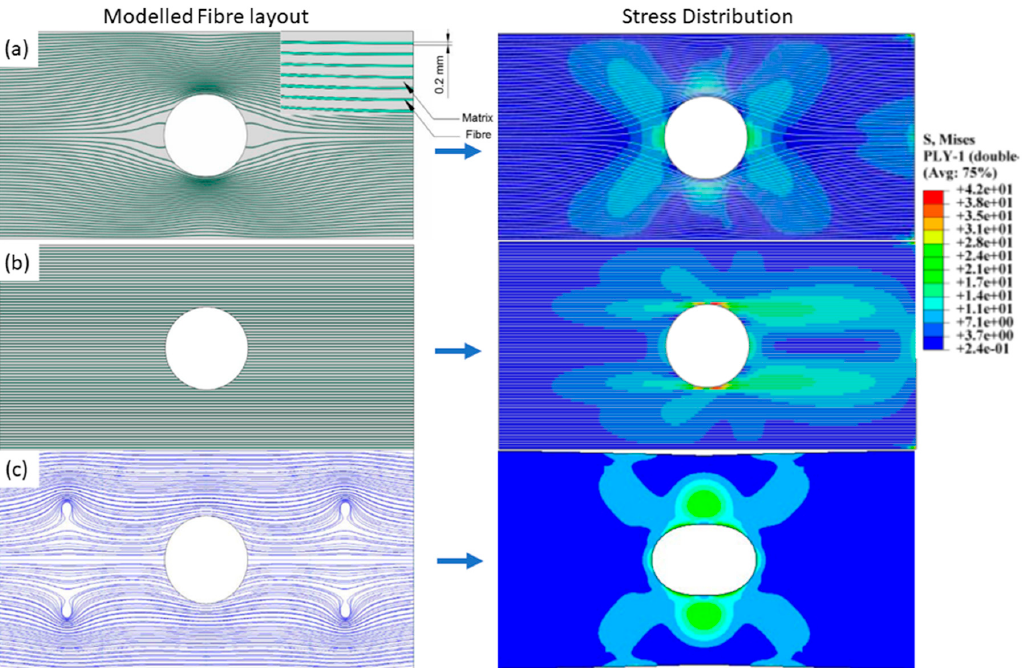
Figure 10 . Modelled fibre layouts (left) and resulting stress heat maps (right). ( a ) represents an ideal fibre placement scenario with reduced strain concentration [68]. ( b ) represents a drilled/cut sample with discontinuous fibres resulting in large strain concentrators. ( c ) represents a cut sample containing fibre vorteces to reduce the strain concentration at the centre hole [67].